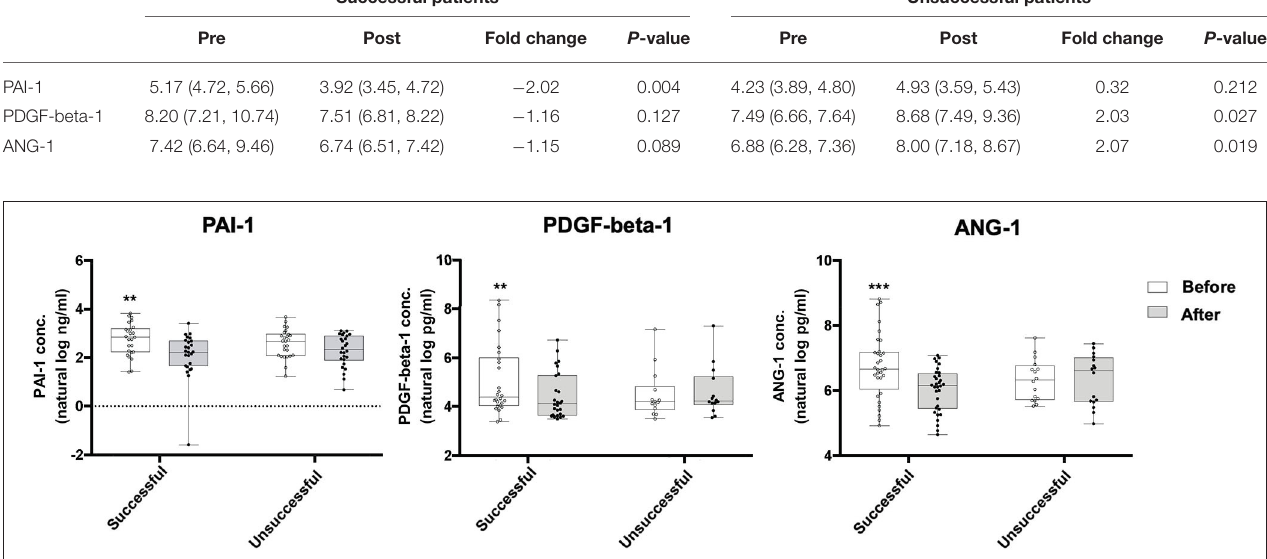
TABLE 5 | Biomarker levels measured by OLINK pre- and post-intervention. Successful patients